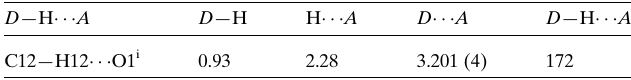
Table 1 Hydrogen-bond geometry (A˚ , (cid:2) ).